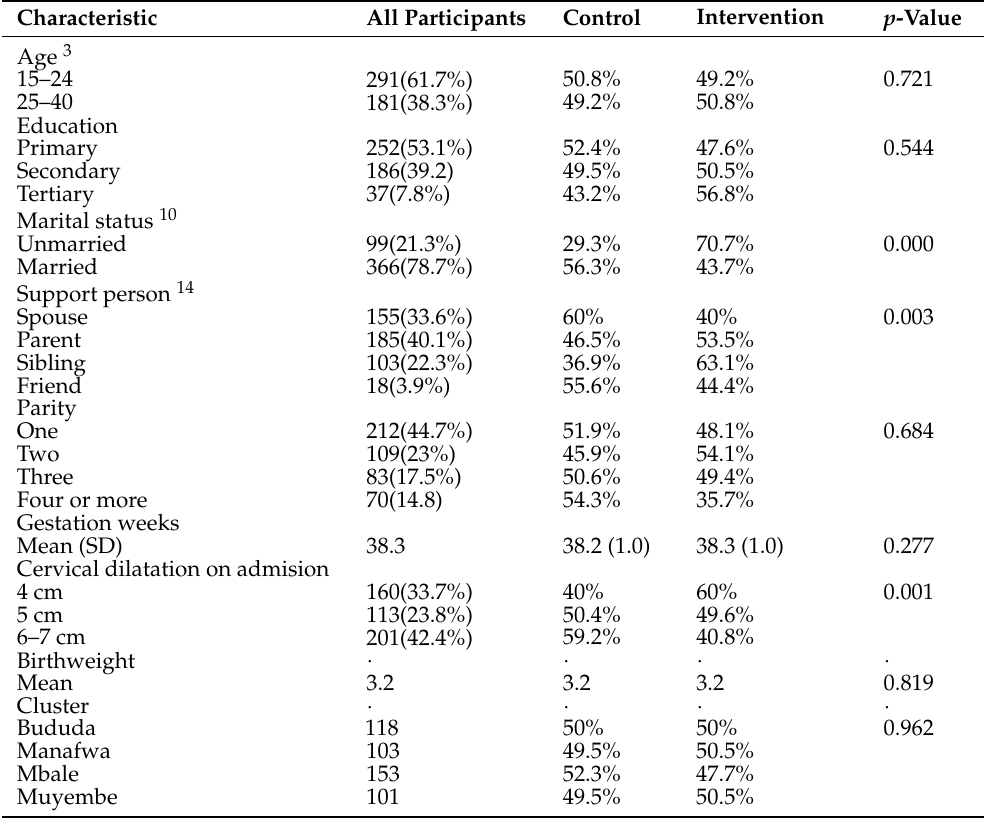
Table 1. Participant